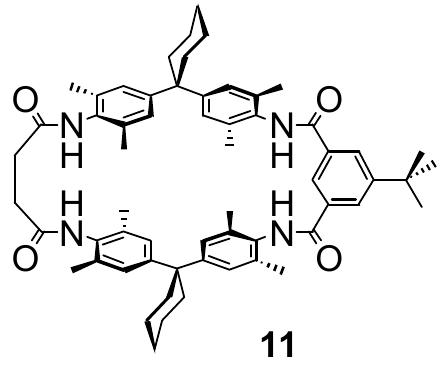
Figure 5. Macrocycle 11 bearing a non-aromatic diamide on one